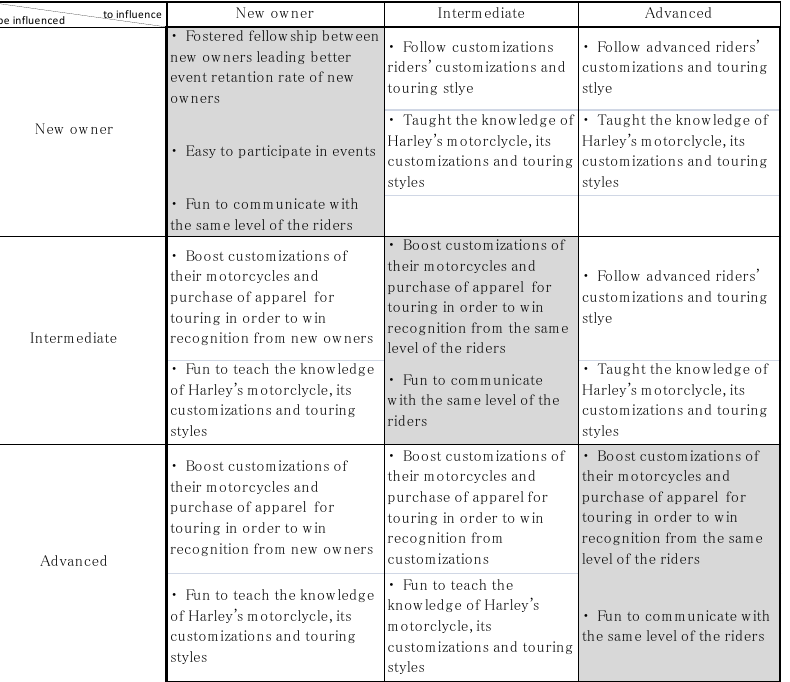
Table 1. The effect of C to C